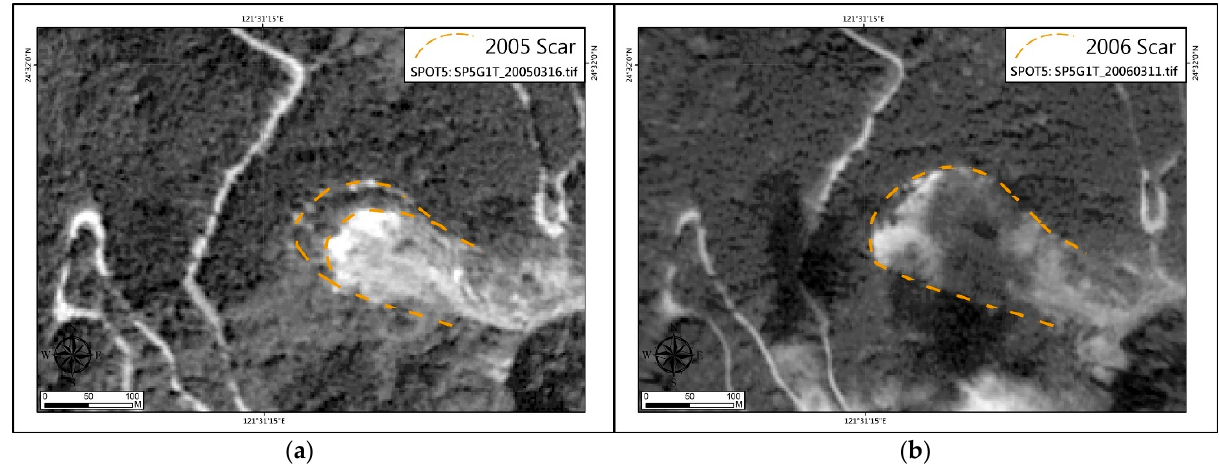
Figure 7. The SPOT5 images acquired on ( a ) 16th March 2005 before, and ( b ) 11 March 2006 after the 2005 Typhoon Haitang event. The orange dash line marked the scars and edges of exposed ground caused by landslide (WGS 84 coordinates). The landslide scar in ( b ) was enlarged and developed further up slope compared to scar in ( a ).